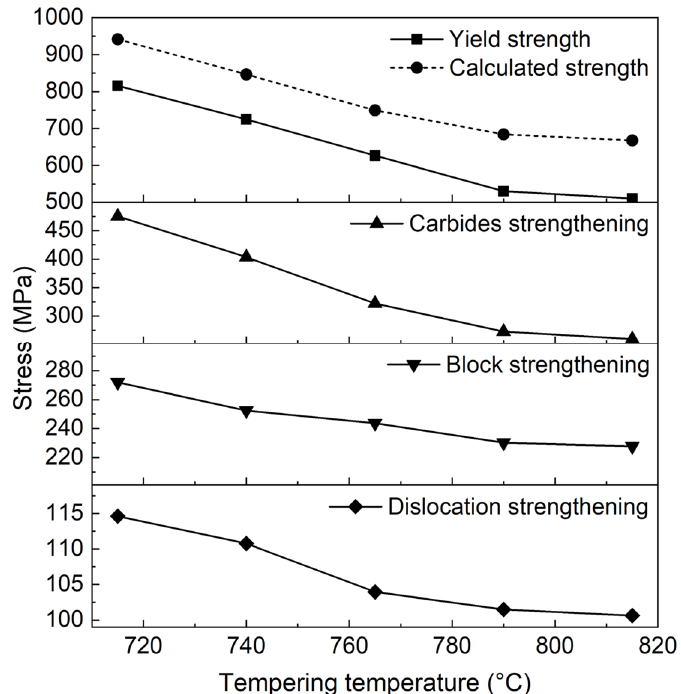
Figure 9. Contributions of the various strengthening mechanisms to the RT yield strength of the T92 heat-resistant steel tempered at different temperatures.